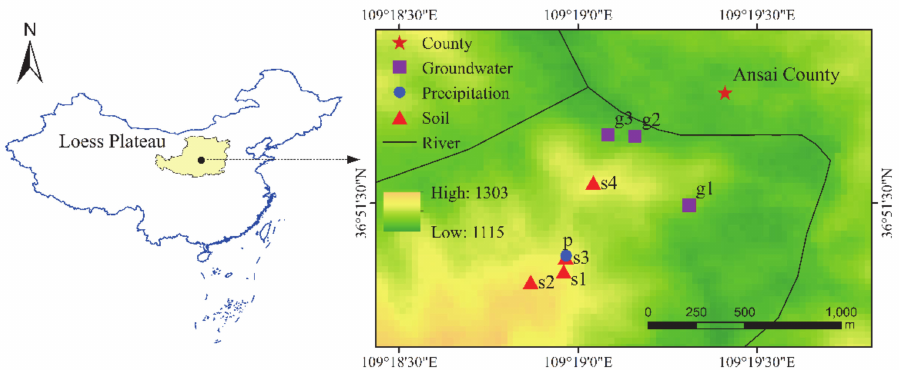
Figure 1. Location of the study area and the sampling sites: Precipitation (p), Groundwater (g1, g2, g3) and soil (s1, cropland; s2, grassland; s3, shrubland; s4,